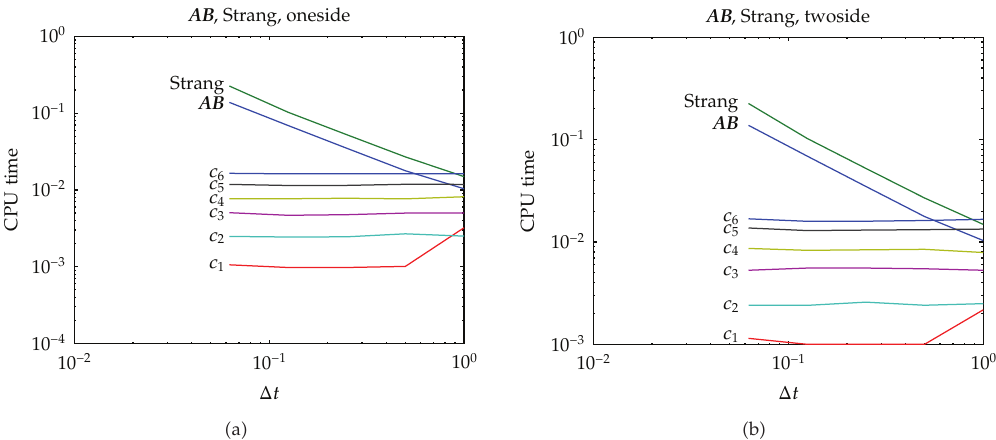
Figure 4: CPU time of the standard splitting scheme (cid:5) a (cid:6) and the iterative schemes (cid:5) b (cid:6) with 1 ,... , 6 iterative